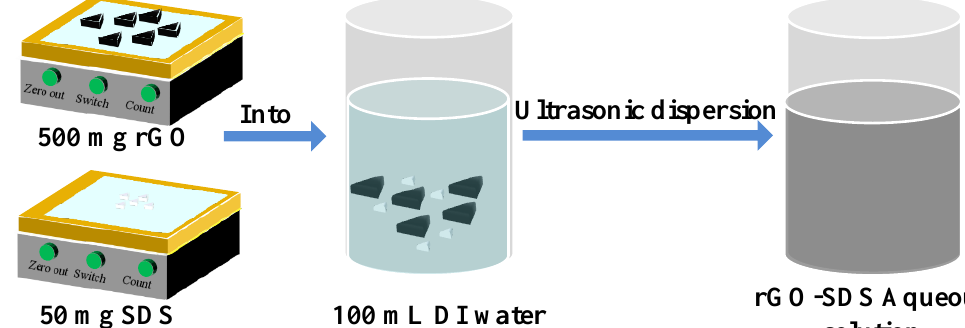
Figure 3. Preparation of moisture-sensitive materials.